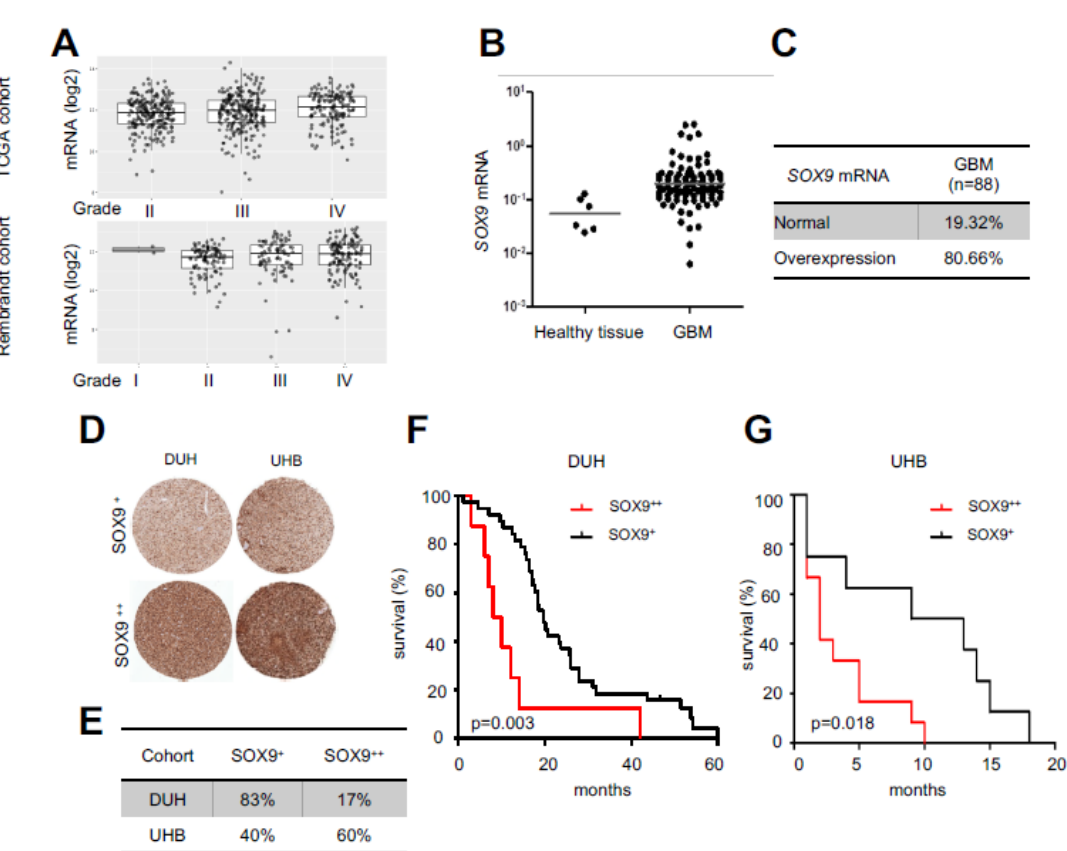
Figure 1. High levels of SOX9 correlate with poor survival: ( A ) SOX9 mRNA expression in grade II, III, and IV of glioma in TCGA and Rembrandt cohorts; ( B ) SOX9 mRNA expression in GB patients from the Donostia University Hospital (DUH; n = 88) relative to the mean expression in healthy brain tissue ( n = 6); ( C ) percentage of patients with “overexpression” and “normal” expression of SOX9 in the DUH cohort; ( D ) representative images of TMAs for SOX9 staining in GB samples from the DUH ( n = 47) and University Hospital Basel (UHB; n = 20) cohorts; ( E ) percentage of patients with “SOX9 + ” (less than 60% of SOX9-positive cells) and “SOX9 ++ ” (equal to or more than 60%) expression from TMAs shown in “C”; ( F ) Kaplan–Meier survival analysis in GB patients from the DUH cohort ( n = 47; p = 0.003) and ( G ) UHB cohort ( n = 20; p = 0.018) based on SOX9 protein expression levels determined by TMA.